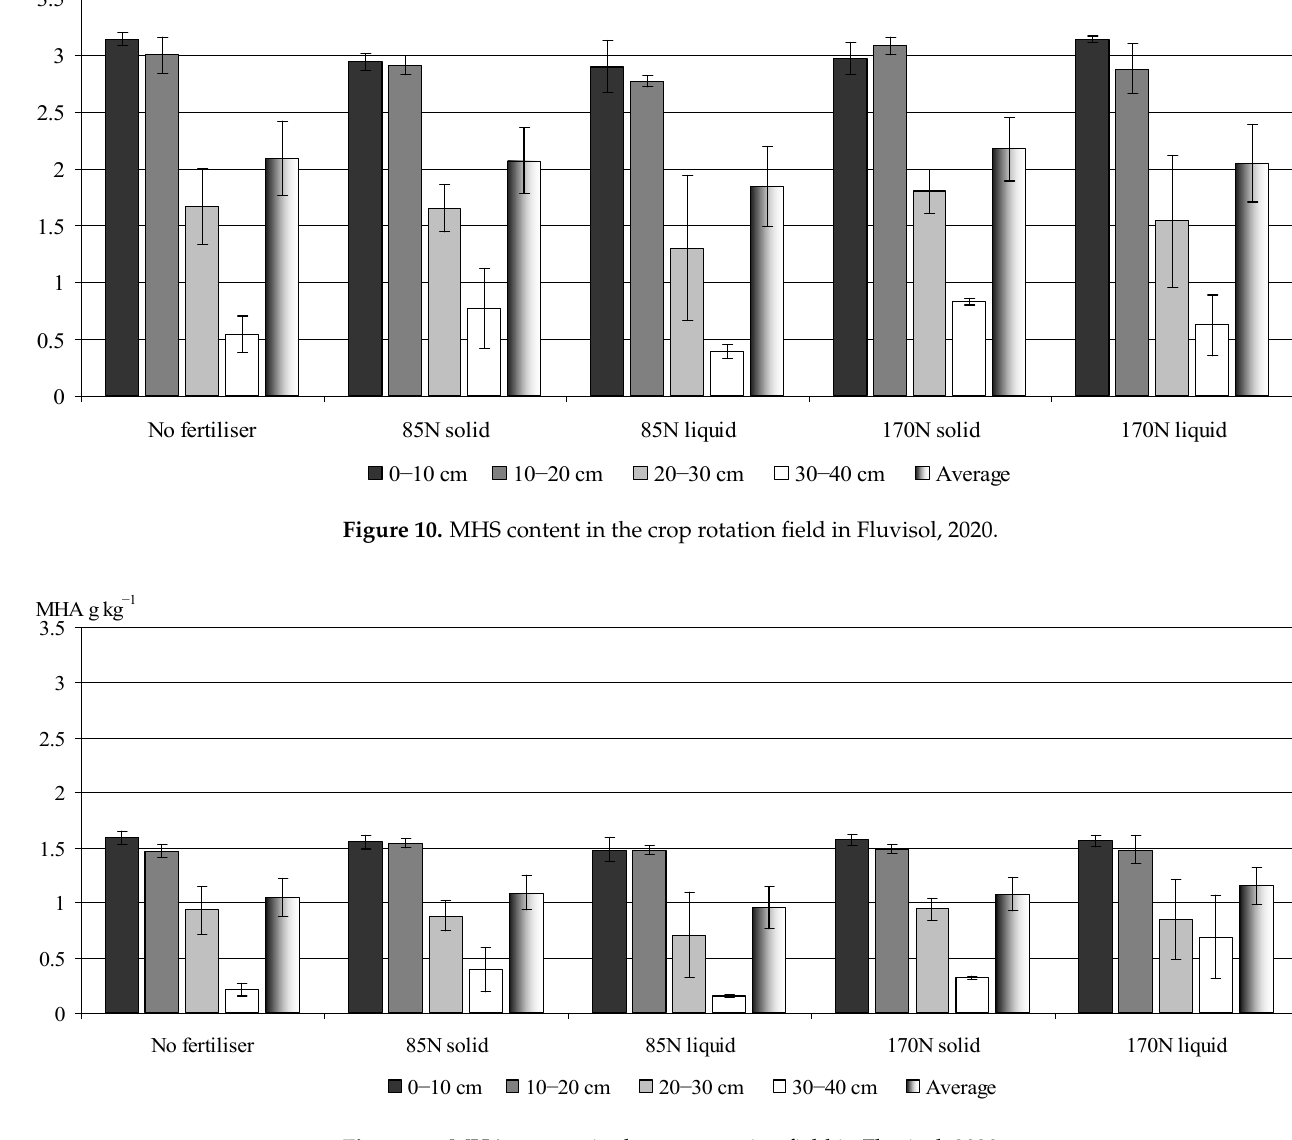
Figure 11. MHA content in the crop rotation field in Fluvisol, 2020 .